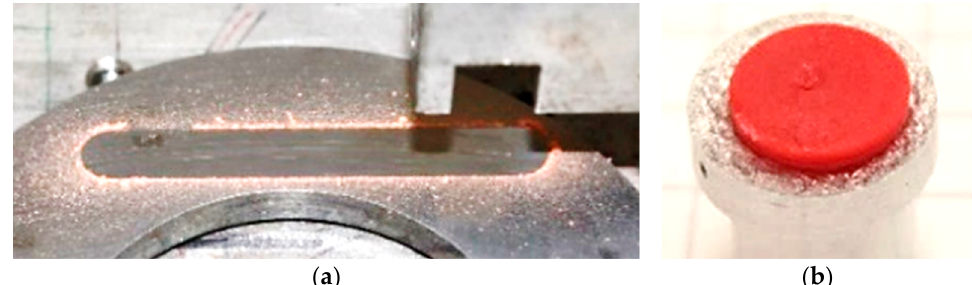
Figure 12. Tribological characterization of HPU premium: ( a ) wear track after testing procedure; ( b ) worn sample after test.